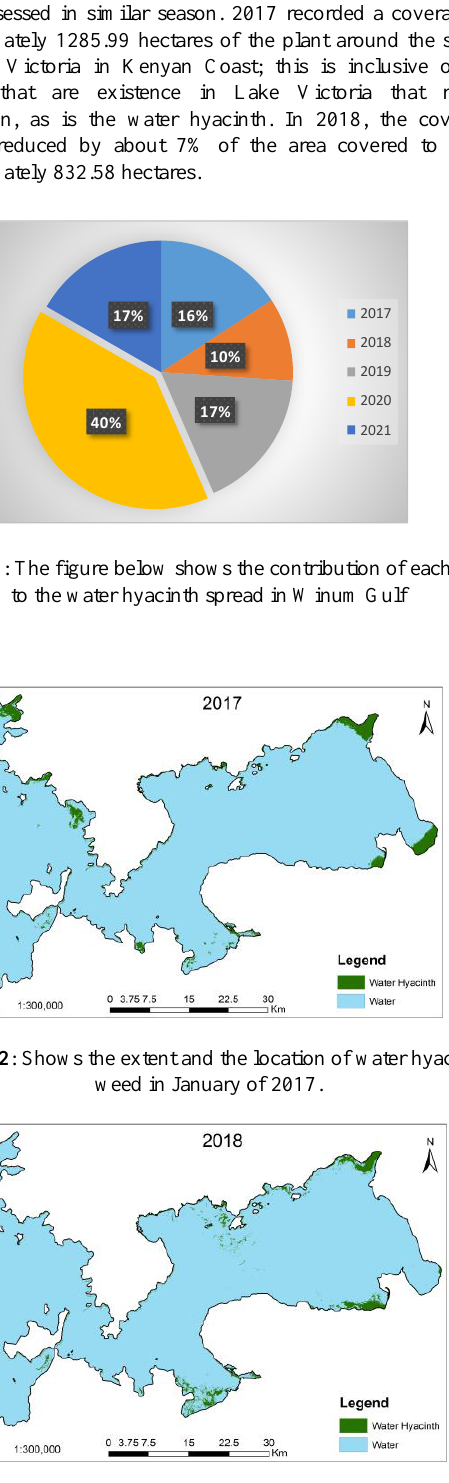
Figure 3: Shows the extent and the coverage location of E. crassipes in Lake Victoria in January of 2017. Compared to the coverage in 2018, the weed settled around the North Western part of the lake, contrary to the 2017 shoreline coverage.